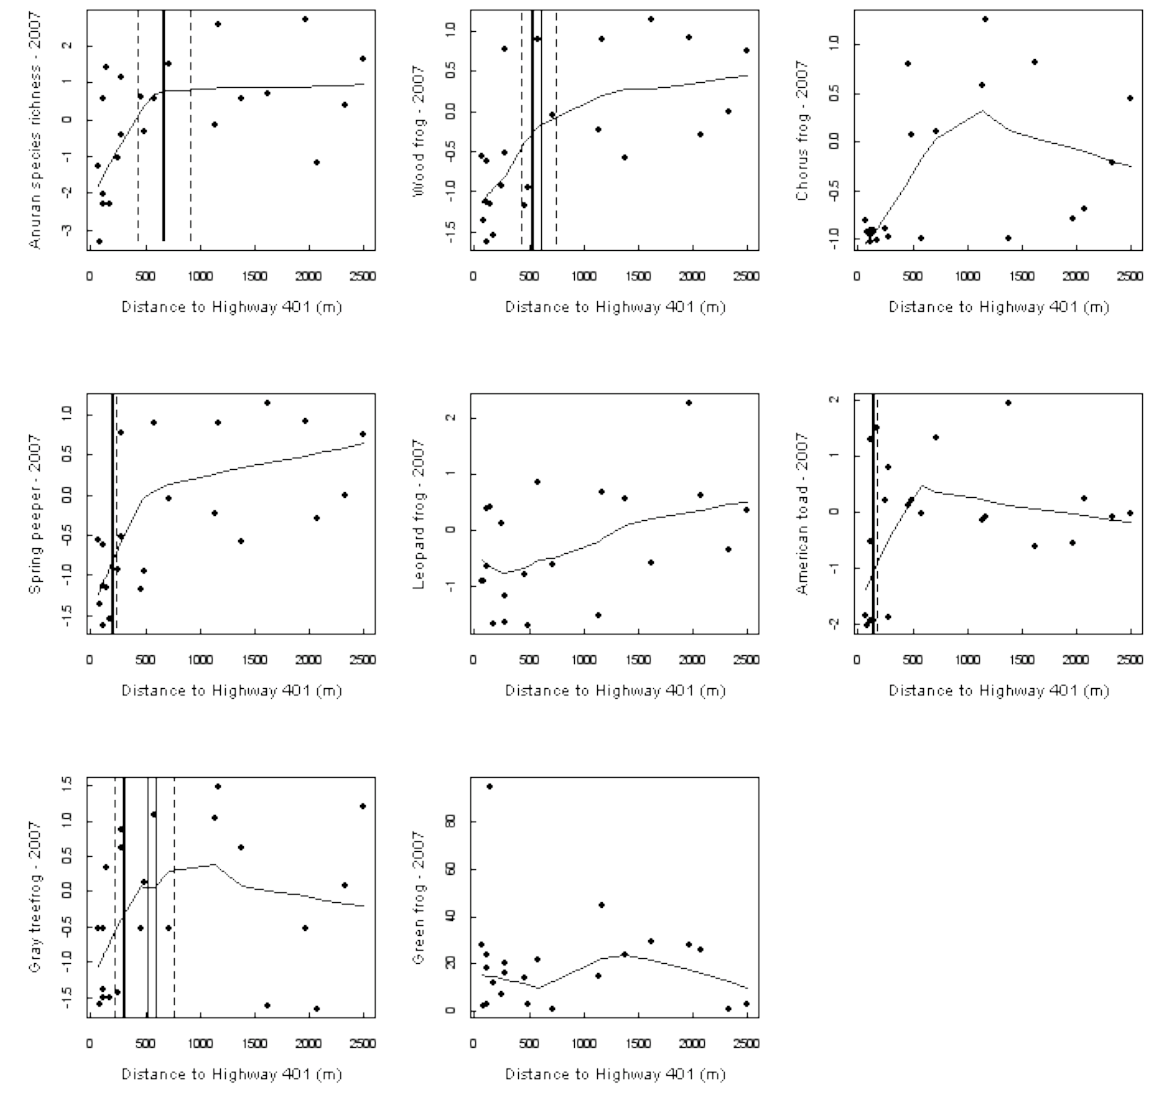
Fig. 4 . Relationship between anuran relative abundance/species richness and distance to Highway 401 (residuals after controlling for significant local predictors; Table 3) in 2007 ( n = 22). The lowess smoothing line is also shown. For species fitted with a piecewise regression model, the breakpoint of the best fitting model is shown by heavy solid vertical line; the second best-fitting breakpoint for the wood frog and the second and third best-fitting breakpoints for the gray treefrog are shown by thin solid vertical lines. One standard deviation below the smallest breakpoint and one SD above the largest breakpoint are shown (dashed vertical lines). For the leopard frog and green frog, relative abundance was defined as the maximum number of adults seen during visual surveys. For all other species, relative abundance was defined as the chorus counts summed over all